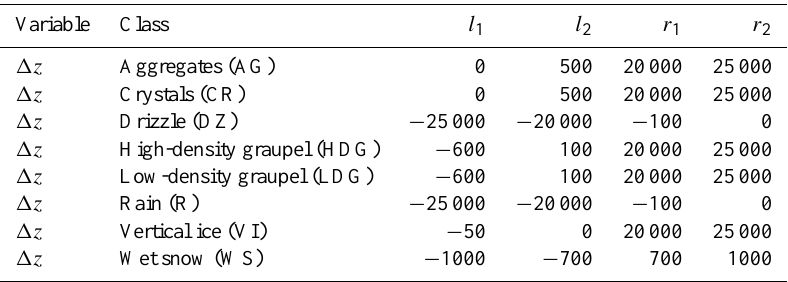
Table B2. Parameters of the trapezoidal membership function T applied to the relative altitude with respect to the 0 ◦ C isotherm ( (cid:49)z [m]). l 1 , l 2 , l 3 , and l 4 are the four vertices of the trapezoid T